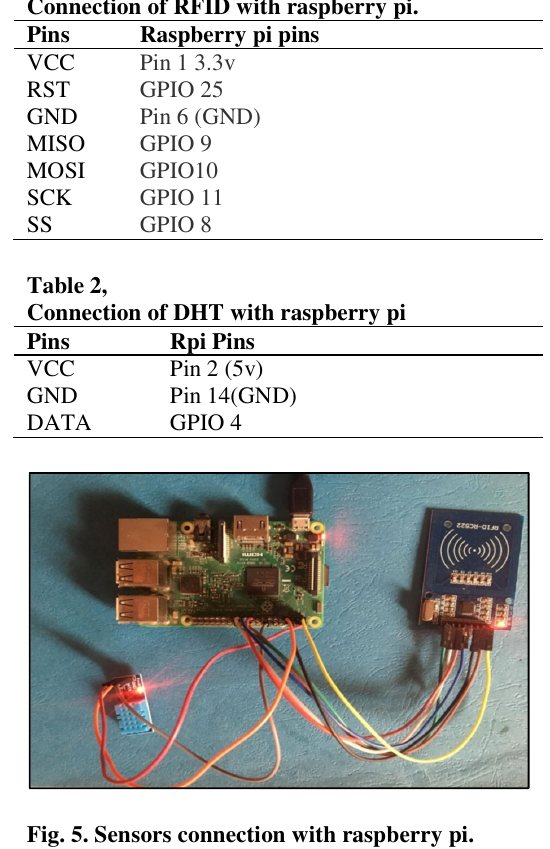
The connection between the cloud, CNC, and the sensor will be used a graphical user interface to make the connection, the same as figure 6.